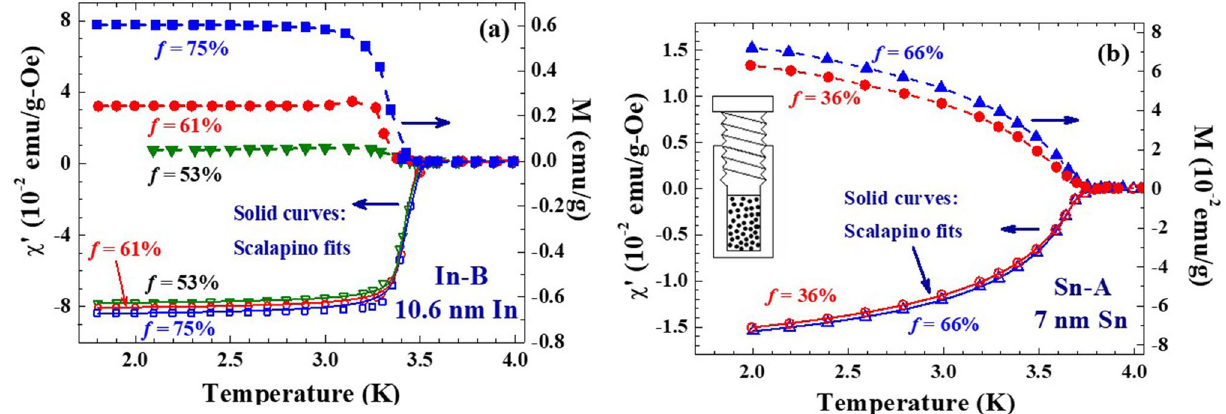
Figure 2. Direct comparison of the M(T) and χ ′ (T) curves of ( a ) 10.6 nm In and ( b ) 7 nm Sn nanoparticle assemblies, taken at various packing fractions. The solid curves on χ ′ (T) indicate the fits of the data to Scalapino’s expression for superconducting screening. The dashed curves on M(T) act as a guide to the eye only. The inset to (b) shows a schematic drawing of the device used to adjust the packing fraction of the nanoparticle assembly.